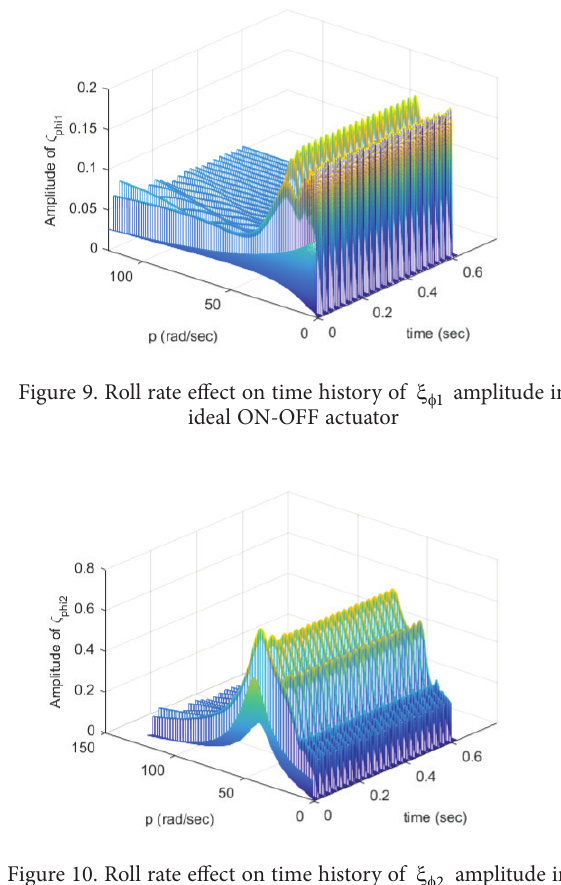
Figure 10. Roll rate eff ect on time history of